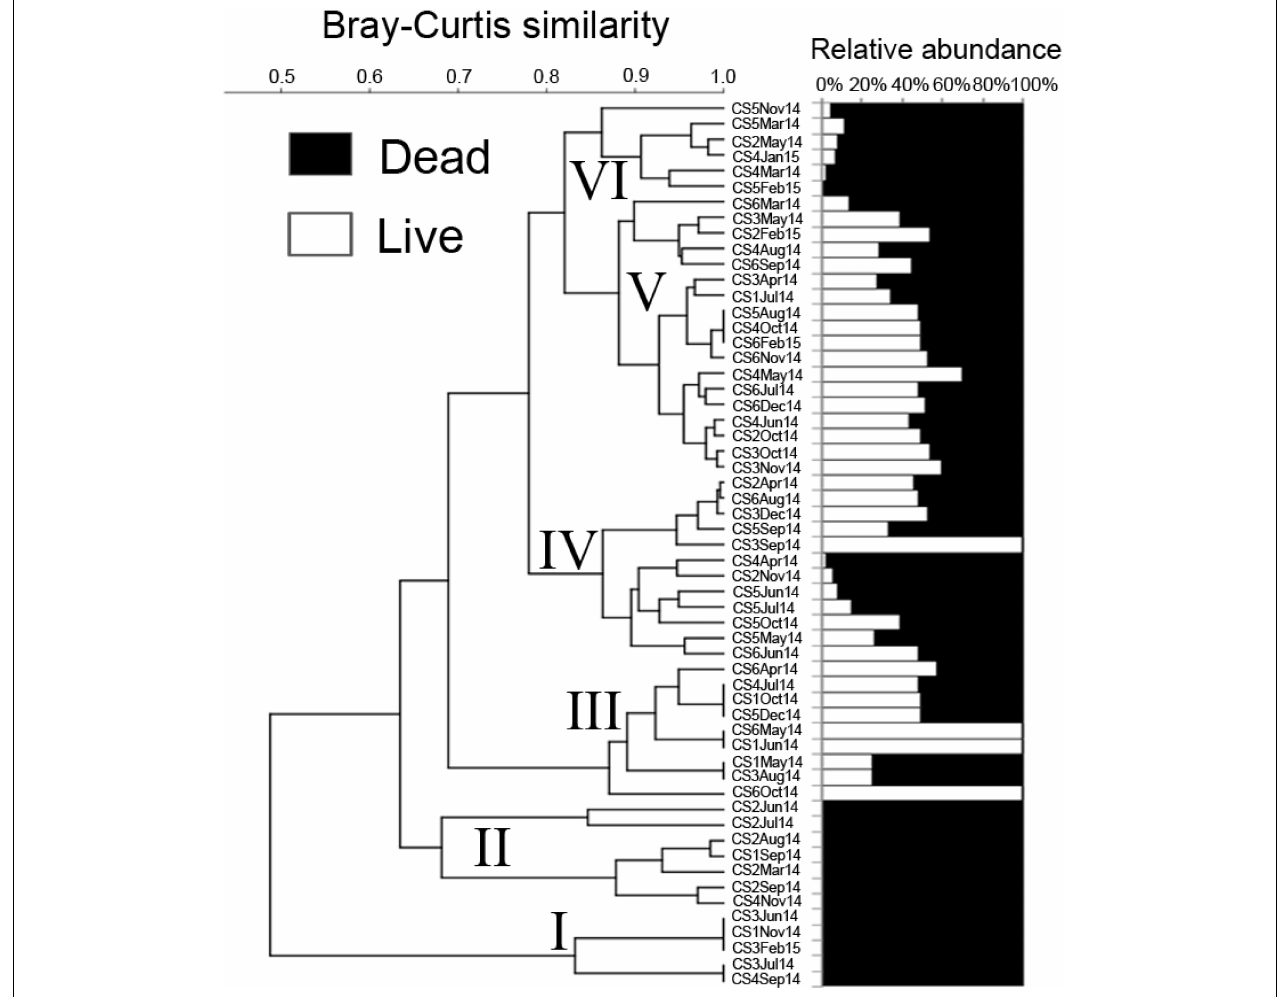
FIGURE 8 | Cluster analysis of Ammonia spp. assemblage using a Bray–Curtis similarity measure. The numerical abundance of live and dead foraminifera were Log (X + 1) transformed prior to the analysis.